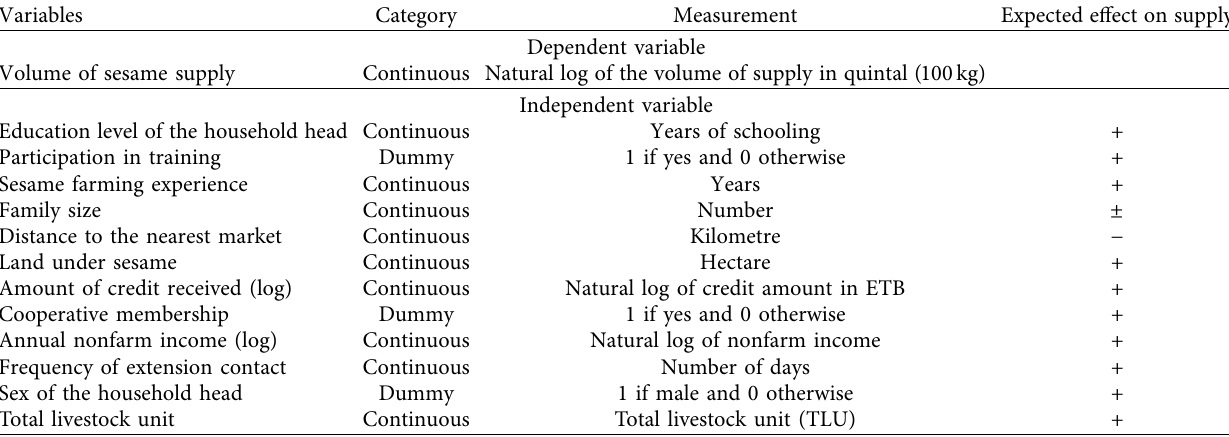
Table 2: Summary of variables definition, measurement, and working hypotheses.